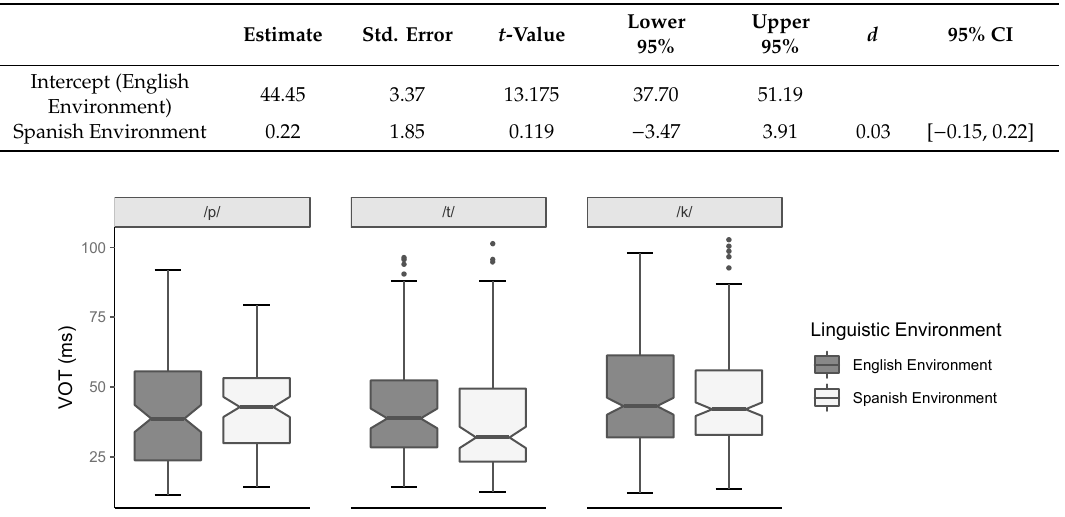
Figure 3. VOT (ms) by linguistic environment and place of articulation.